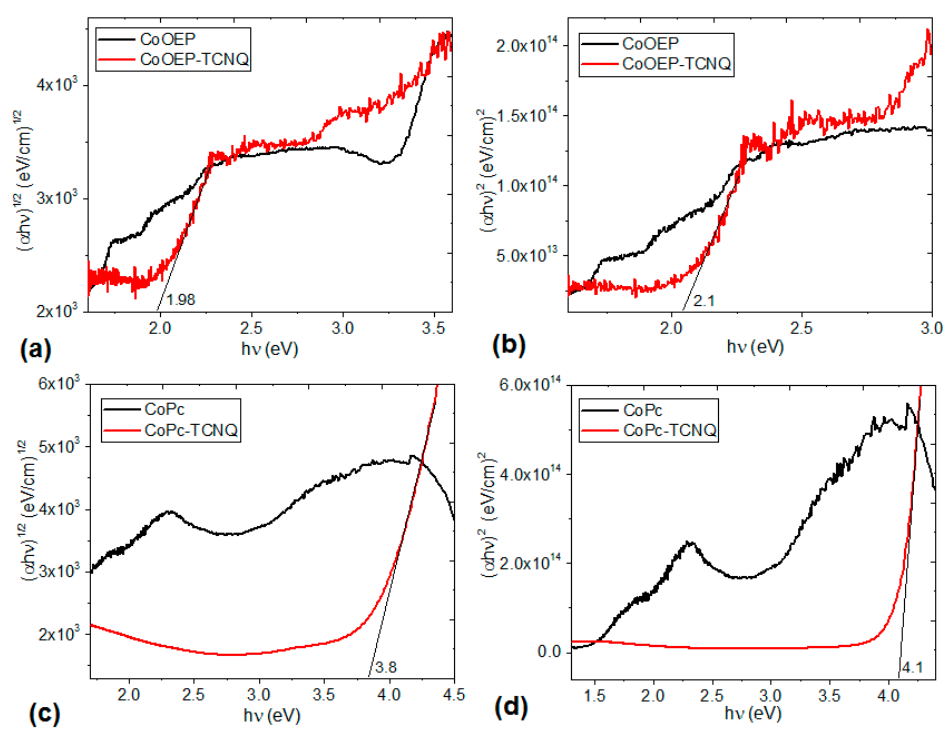
Figure 8. Plots of ( α h ν ) 1 / 2 and ( α h ν ) 2 vs. h ν for the ( a , b ) CoOEP-TCNQ and ( c , d ) CoPc-TCNQ films and their precursors CoOEP and CoPc.